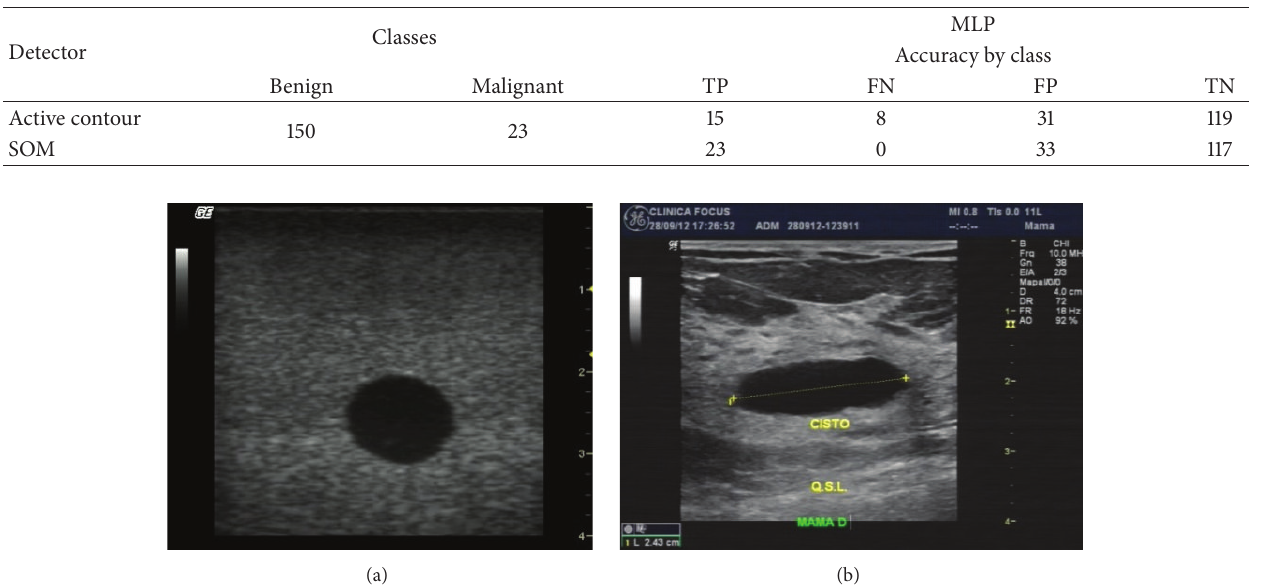
Table 7: Classification of actual clinical images.